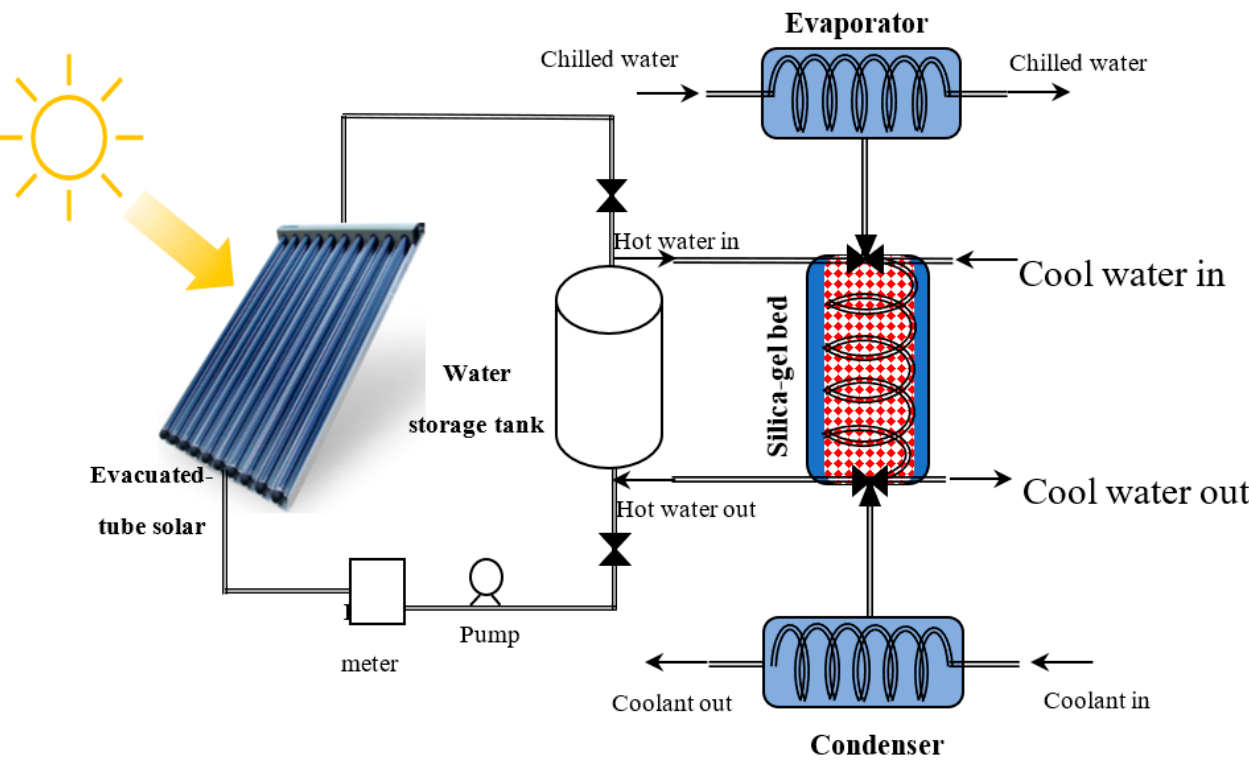
Figure 1. Schematic diagram of solar A/D cooling cycle.